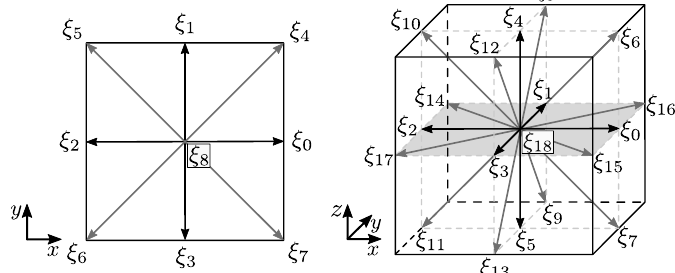
Figure 2. Discrete velocity sets for D2Q9 and D3Q19